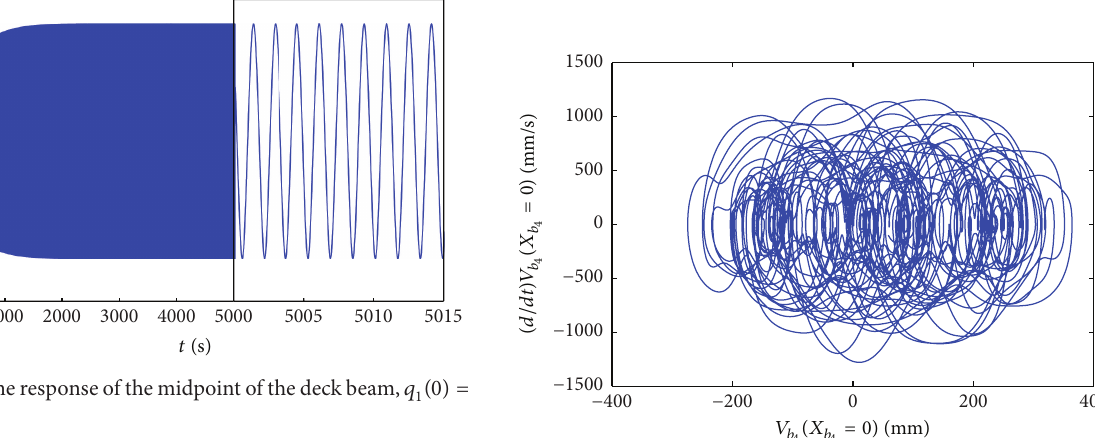
Figure 18: Phase portraits of the response of the midpoint of the deck beam for different initial conditions, 𝑁 = 1 .